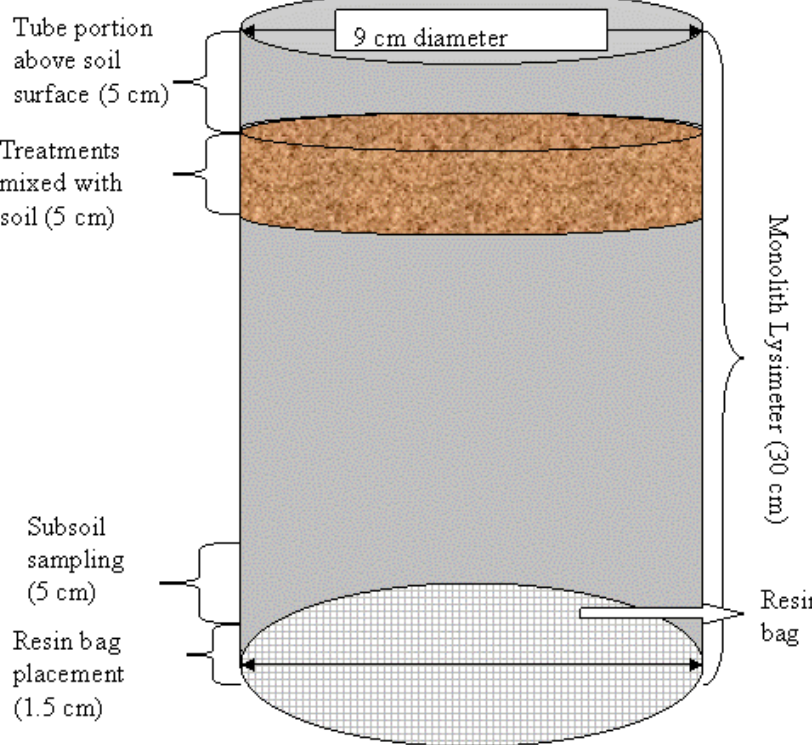
FIGURE 2. Schematic diagram showing the intact leaching column modified with ion exchange